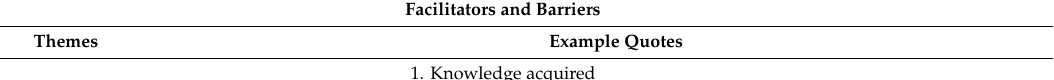
Table 5. Qualitative analysis, representative quotes for key facilitators / barriers.